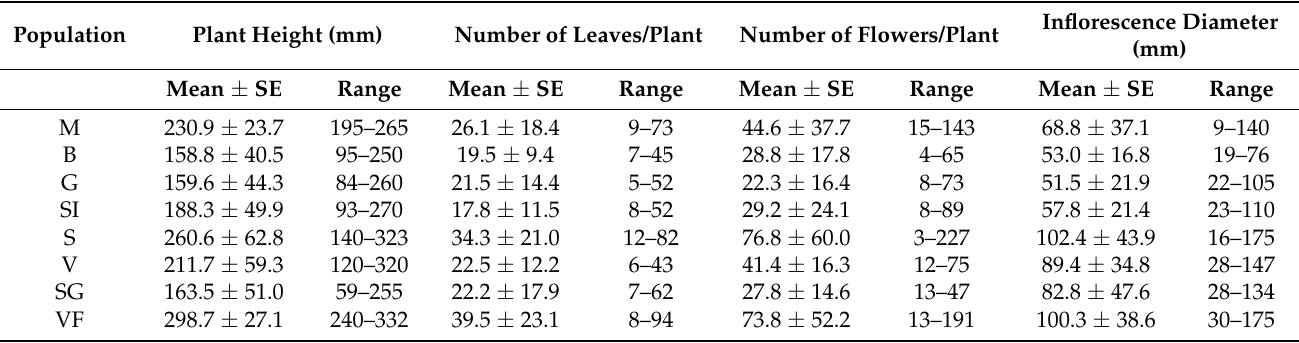
Table 1. Morphologic data of A. exscapus subsp. transsilvanicus samples recorded from eight analyzed populations.